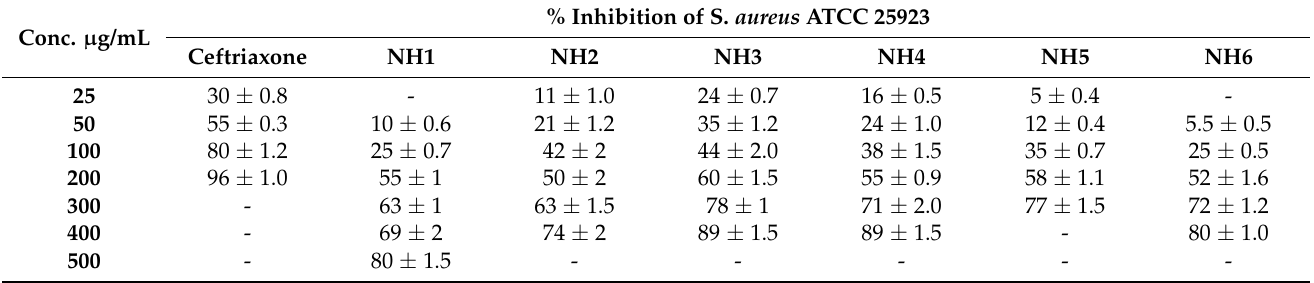
Table 3. Minimum inhibitory concentration of synthesized compounds against Staphylococcus aureus